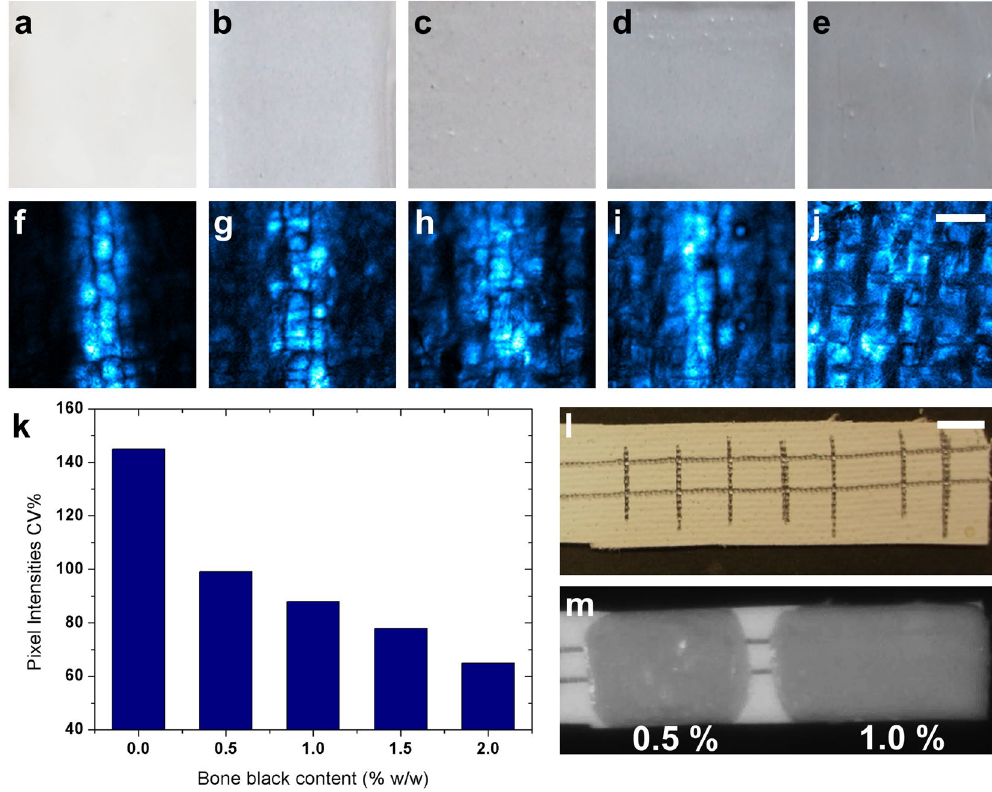
Figure 3. Sensitivity limits of photoacoustic imaging. ( a – e ) Brightfield images of canvas samples covered with oil paint layers containing zinc white and bone black pigments at gradually increasing concentration of the latter in the range of 0–2% at 0.5% increments. ( f – j ) Corresponding photoacoustic images revealing an underlying vertical line sketch presenting progressive contrast degradation for increasing bone black concentration. Scalebar: 1 mm. ( k ) Mean normalized standard deviation of pixel intensities (CV%) for images ( f – j ) versus bone black concentration, as a quantitative measure of contrast degradation. ( l ) Brightfield view of pencil lines sketched on canvas sample. ( m ) NIR optical image recorded at 1200 nm of the canvas sample shown in ( l ) coated with zinc white mixed with bone black paint at 0.5 and 1% by weight. Scalebar: 1